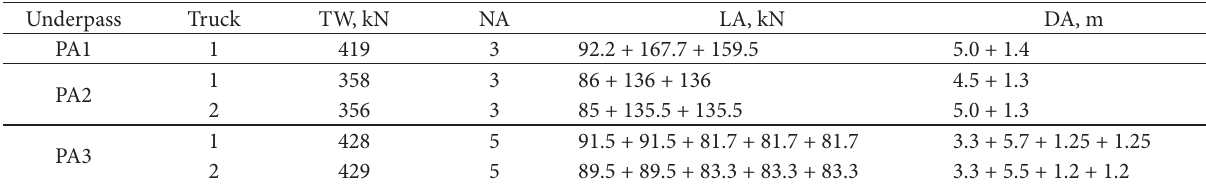
Table 2. Characteristics of the trucks used in the load tests Underpass